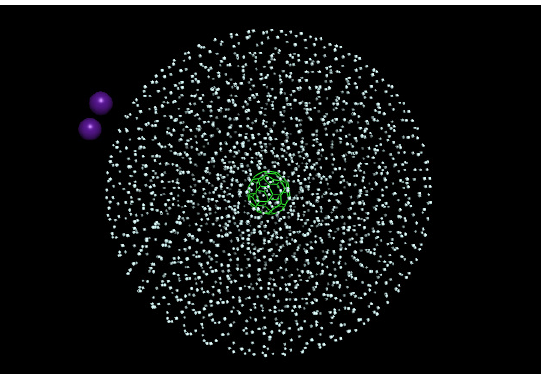
Figure 4. Initial structure of Cs 2 -C 60 @He 2090 complex obtained by a combined evolutionary algorithm and geometric extension, see